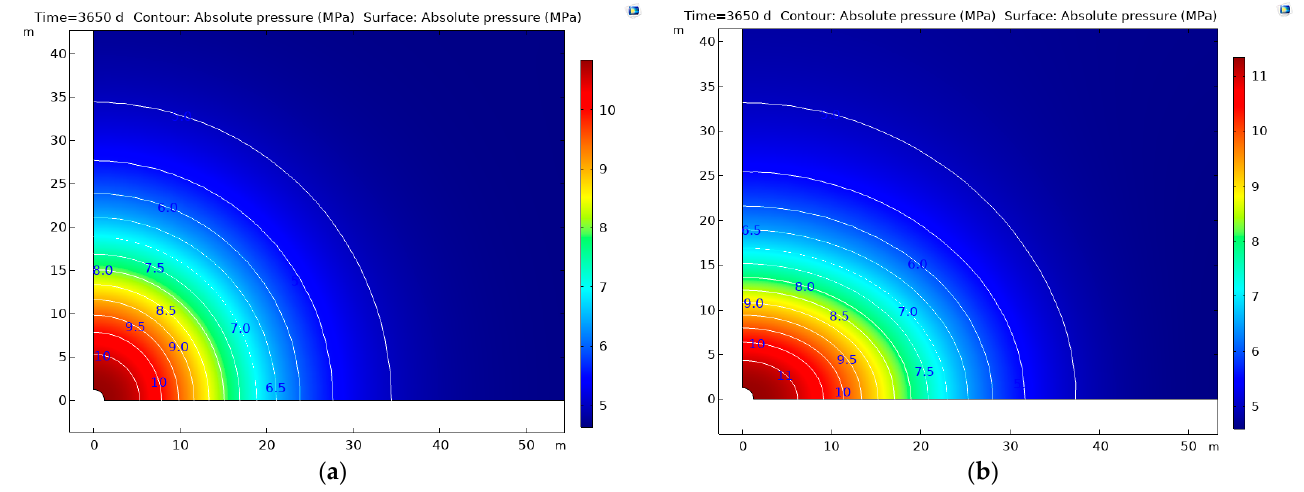
Figure 12. UDC variant: distribution of pore pressure at the end of the heating phase: ( a ) in the case of isotropic stress conditions and isotropic properties: ( b ) in the case of anisotropic stress conditions and anisotropic properties.